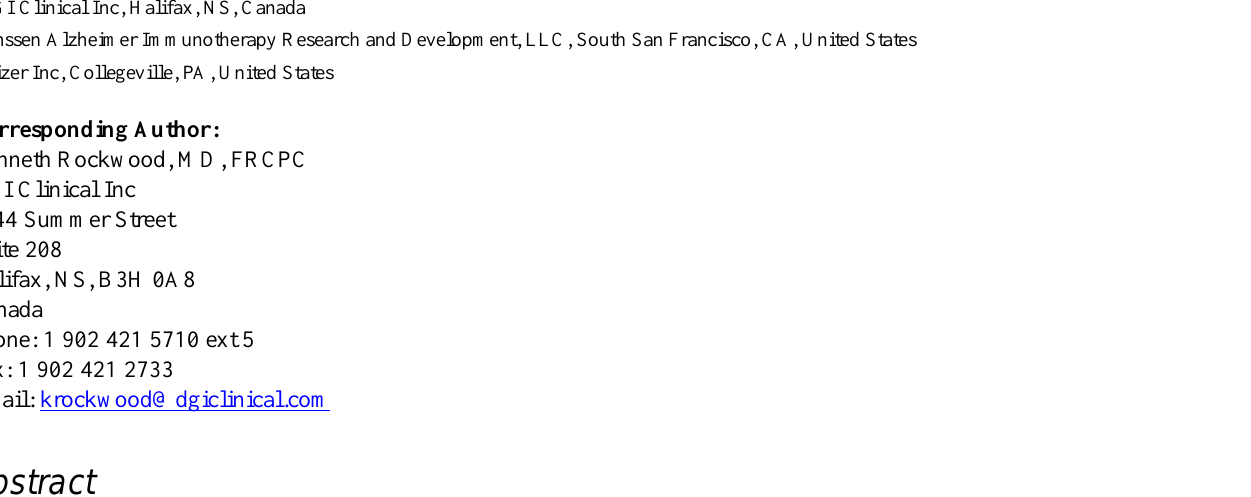
Artificial Neural Networks; World Wide